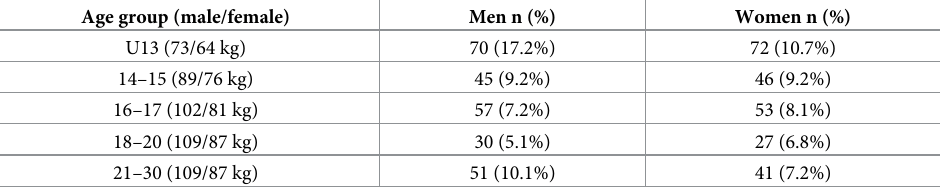
Table 3. Number of athletes in the unlimited body weight categories (IWF/USAW body weight classes for age cat- egories as of 2018).